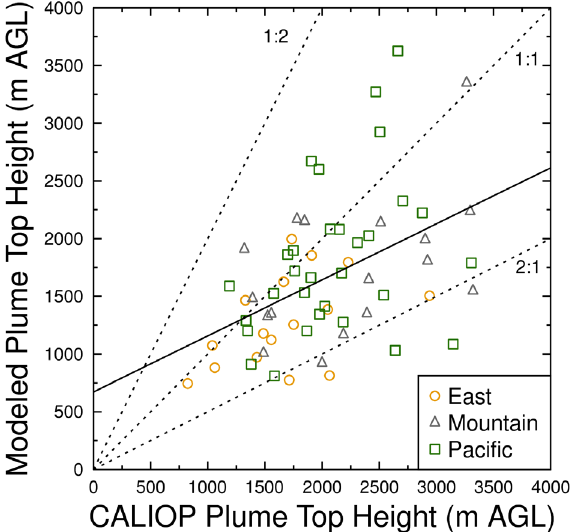
Figure 9. Results of the regression analysis of the CALIOP observations ( x -axis) and the modeled plume height data ( y -axis). Data points are color coded by region as shown on Figure 10. Also shown on the plot are the linear regression (solid line) and 1:2, 1:1, and 2:1 lines (dotted black